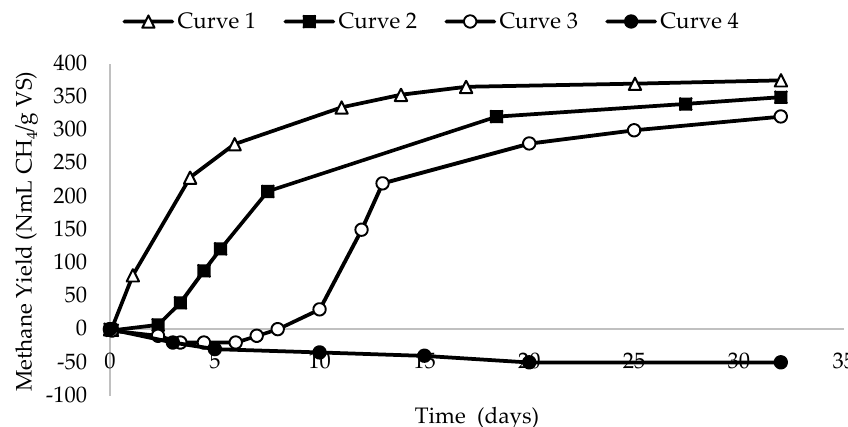
Figure 2. Example of different methane yield curves for four different test materials.